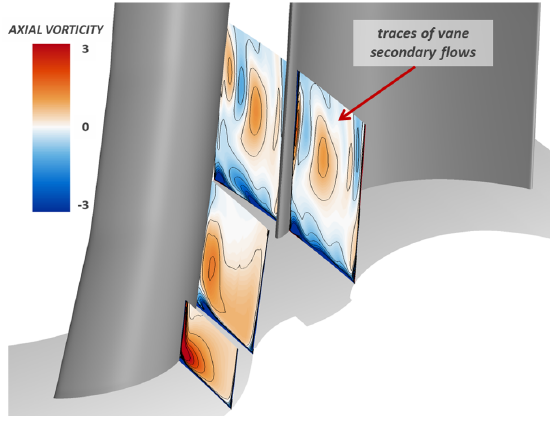
Figure 9. Axial vorticity contours: unnsteady stator–rotor interaction.